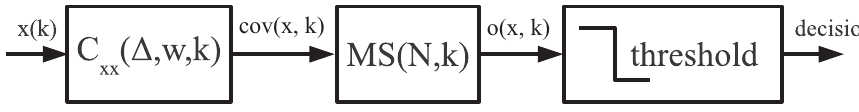
Figure 1. Flow chart of the algorithm in